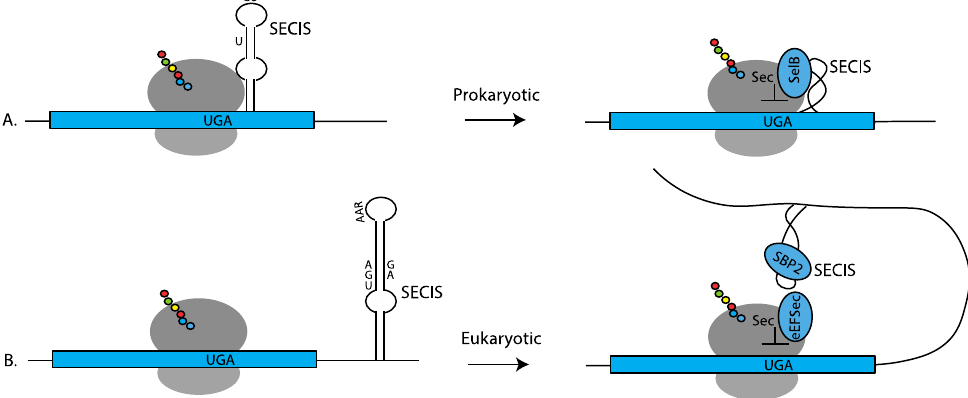
Figure 1. Prokaryotic versus eukaryotic Sec insertion showing the SECIS elements and core compo- nents required for Sec-tRNA Sec delivery to the ribosome. ( A ) In prokaryotes, the SECIS element is located just downstream from the UGA codon within the coding sequence. The bulged U and G U nucleotides required for SelB binding are shown. SelB binds to the SECIS element and delivers the Sec-tRNA Sec to the ribosome for UGA recoding. ( B ) In eukaryotes, the SECIS element is located in the 3 ′ UTR. The SECIS-binding protein, SECISBP2 (SBP2), recruits the Sec-specific elongation factor EEFSEC (eEFSec) to deliver Sec-tRNA Sec to the ribosome for UGA recoding. On the right-hand side of the figure, the SECIS elements are depicted as a helix.